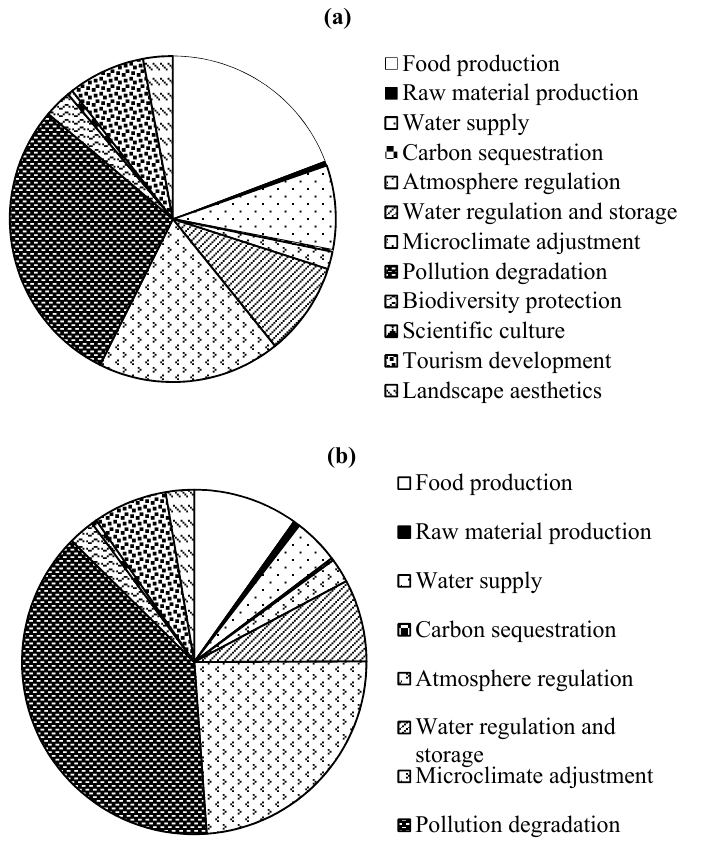
Figure 5. Proportion of service benefits for second-class indices: food production, raw material production, water supply, carbon sequestration, atmosphere regulation, water regulation and storage, microclimate adjustment, pollution degradation, biodiversity protection, scientific culture, tourism development, and landscape aesthetics services: ( a ) before optimization; and ( b ) after optimization.